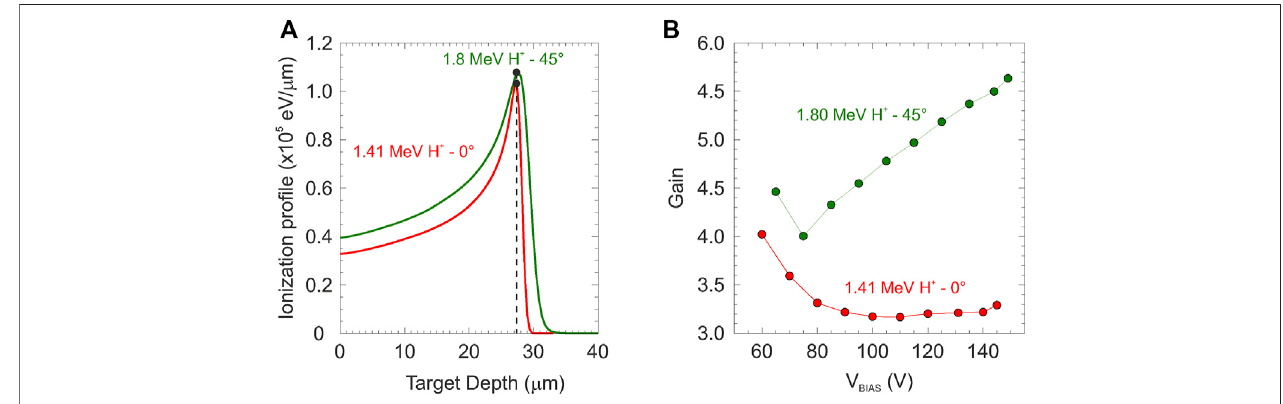
FIGURE 9 | (A) Ionization pro fi les for normal incidence of 1.41 MeV protons and for 1.8 MeV protons with 45 0 incidence angle. (B) Dependence of gain on bias voltage for sample